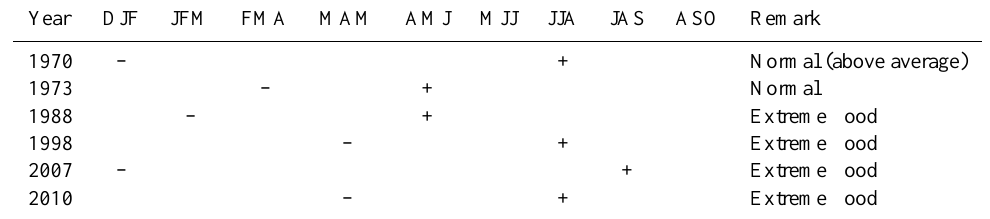
Table 4. El Niño followed by La Niña and occurrence of extreme flood conditions.